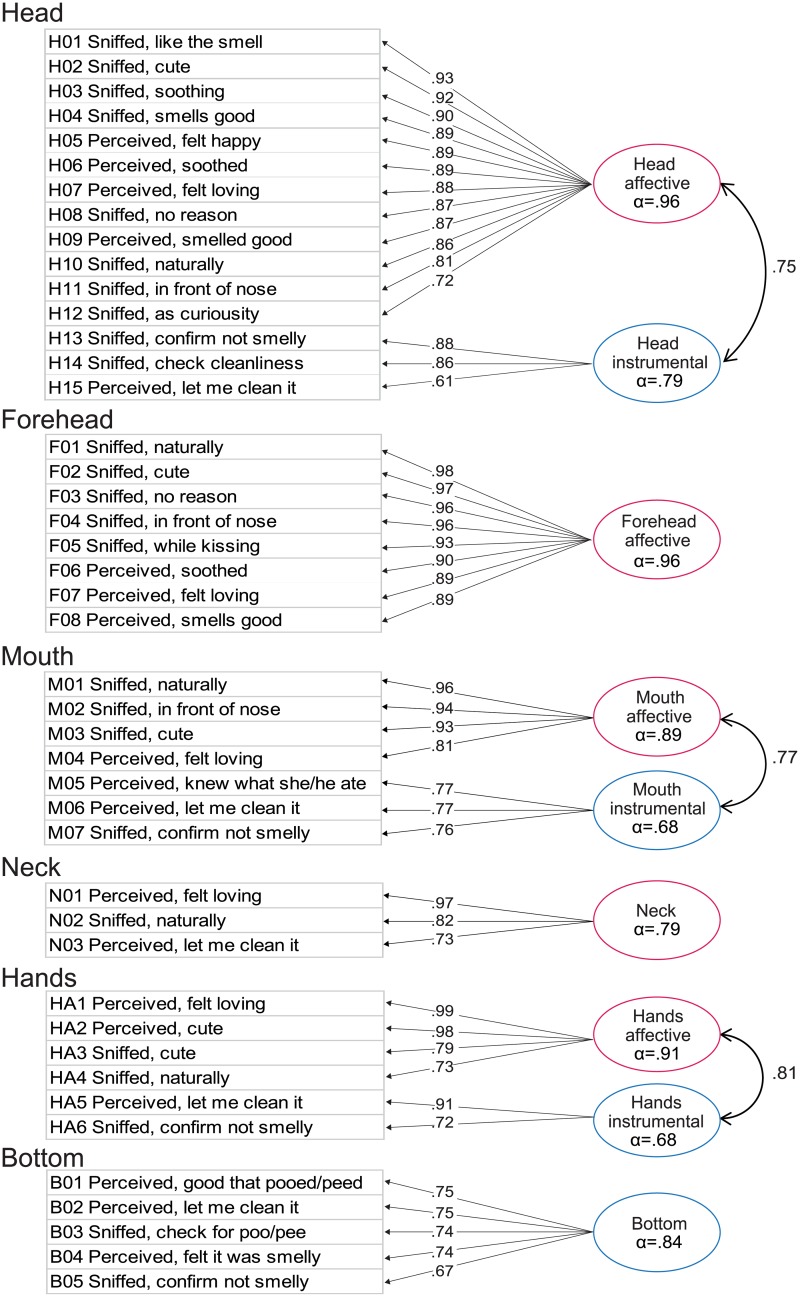
Factor structure of the Child Odor in Parenting scale (COPs) (n = 888).Abbreviated questionnaire items, standardized factor loadings, and correlation coefficients are presented for each body part. Item number corresponds to those shown in Table 1. Information on model fit for the selected models as well as for the alternative models is provided in S1 Table. Instrumental factors are shown in blue, and the Affective factors are in pink.